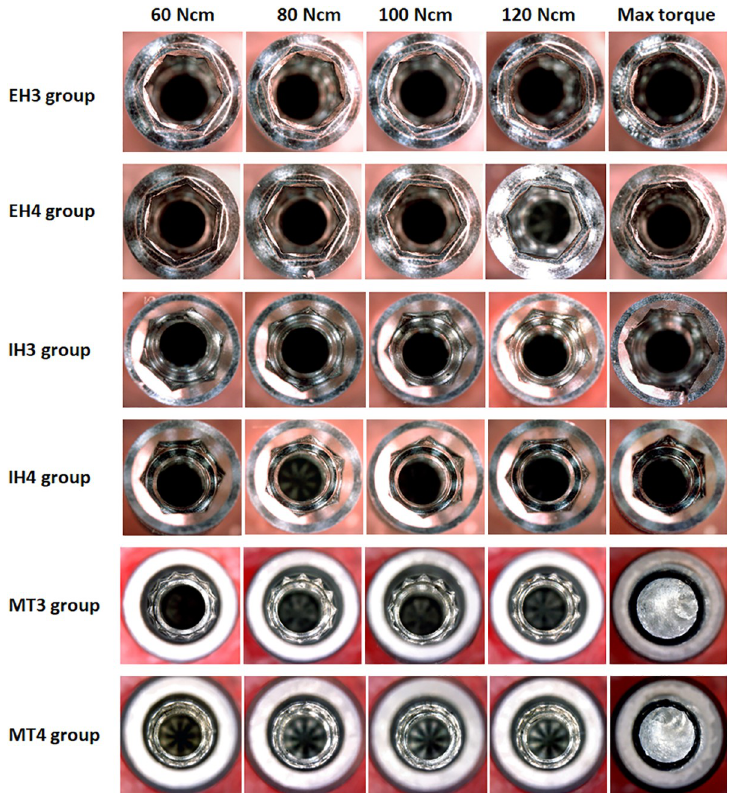
Fig 5. Representative images of the samples of each group are shown after the application of the predetermined torque values.